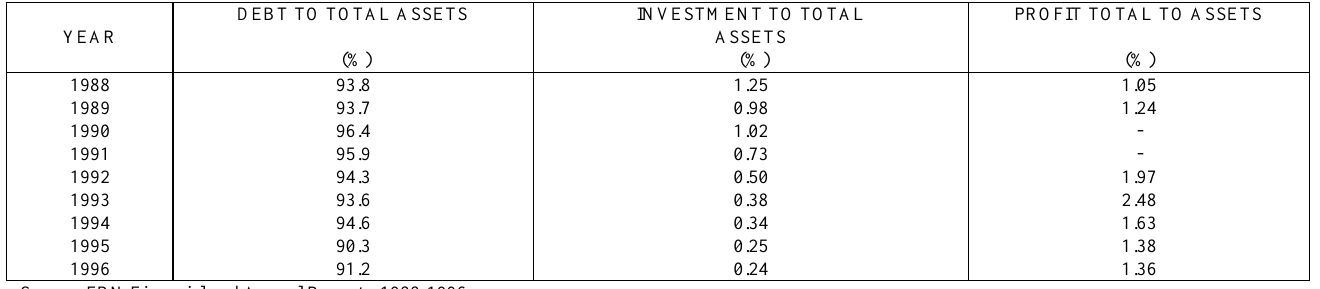
TABLE 11: UNITED BANK OF AFRICA (UBA) YEAR